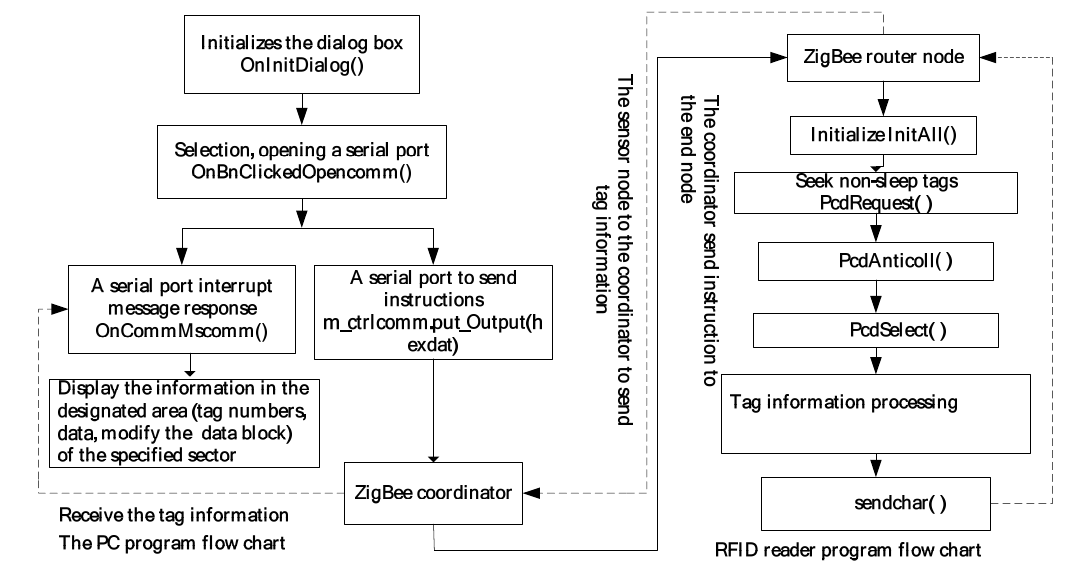
Figure 9. The communication flow chart of RFID reader and host computer.